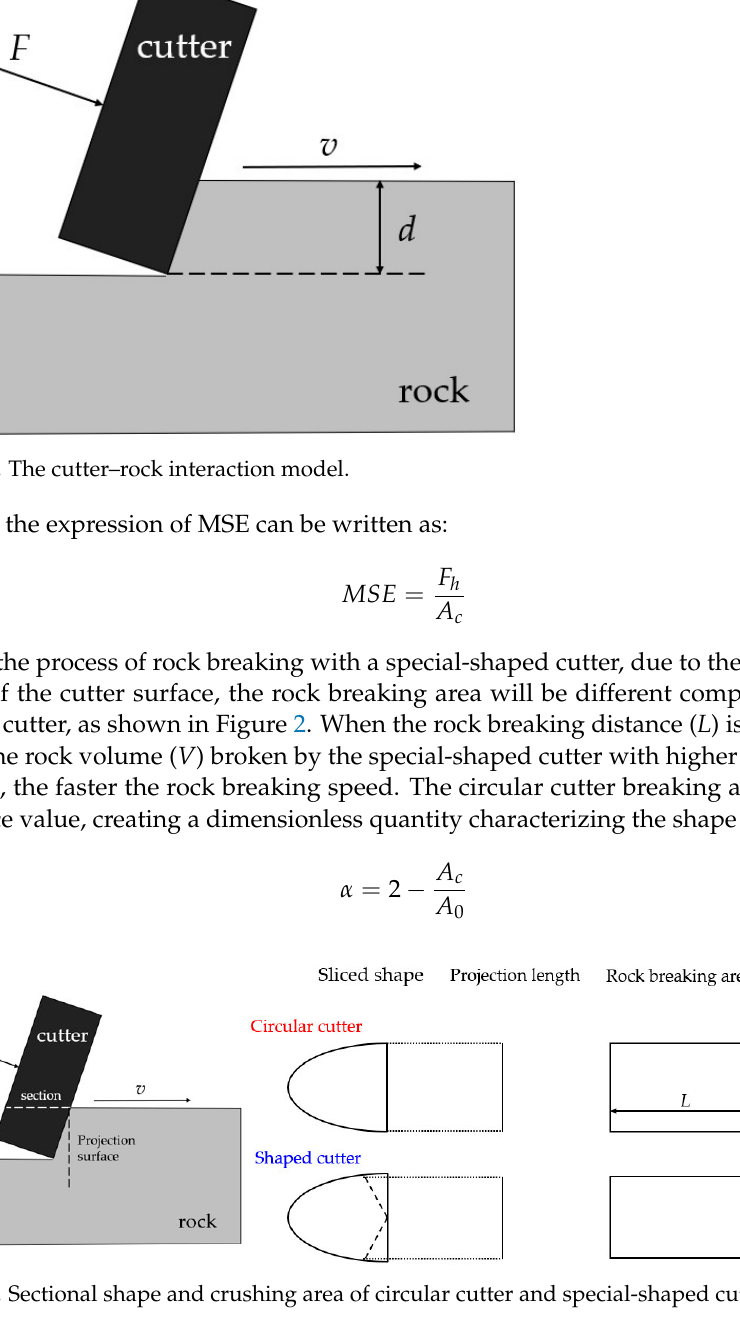
Figure 2. Sectional shape and crushing area of circular cutter and special-shaped cutter.